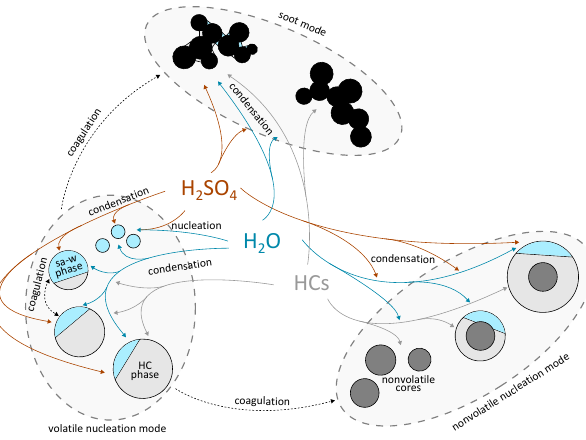
Figure 2. Modeled aerosol processes, modes, components, and phases. Detailed information on them are explained in Sect. 2.2.3 and in Appendix